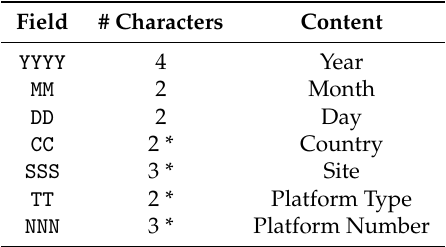
Table 1. The encoding for CSV file names.